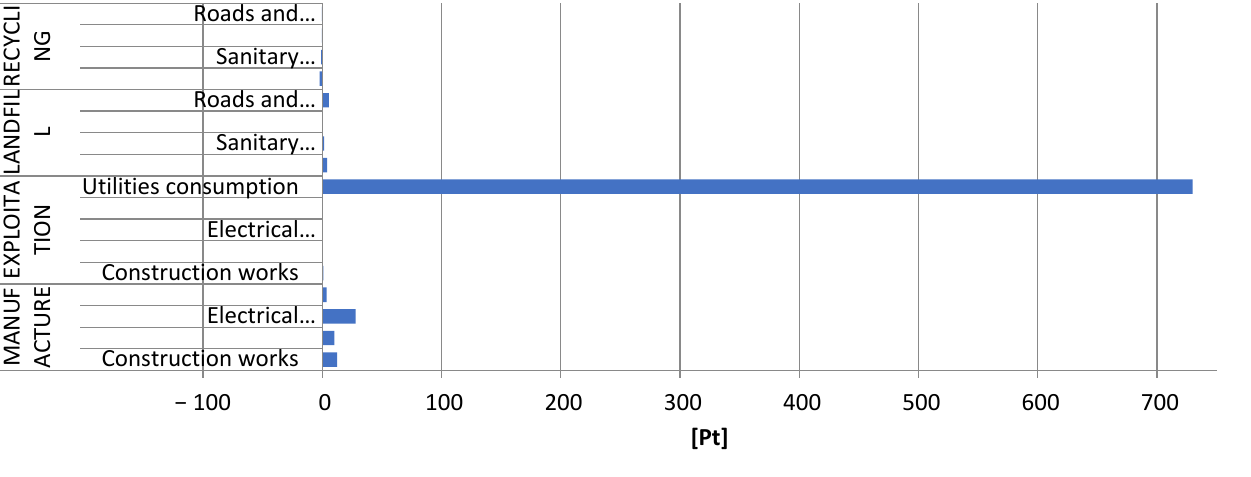
Figure 10. Results of grouping and weighing the environmental consequences of emissions of compounds causing global warming occurring in the life cycle of the research object.